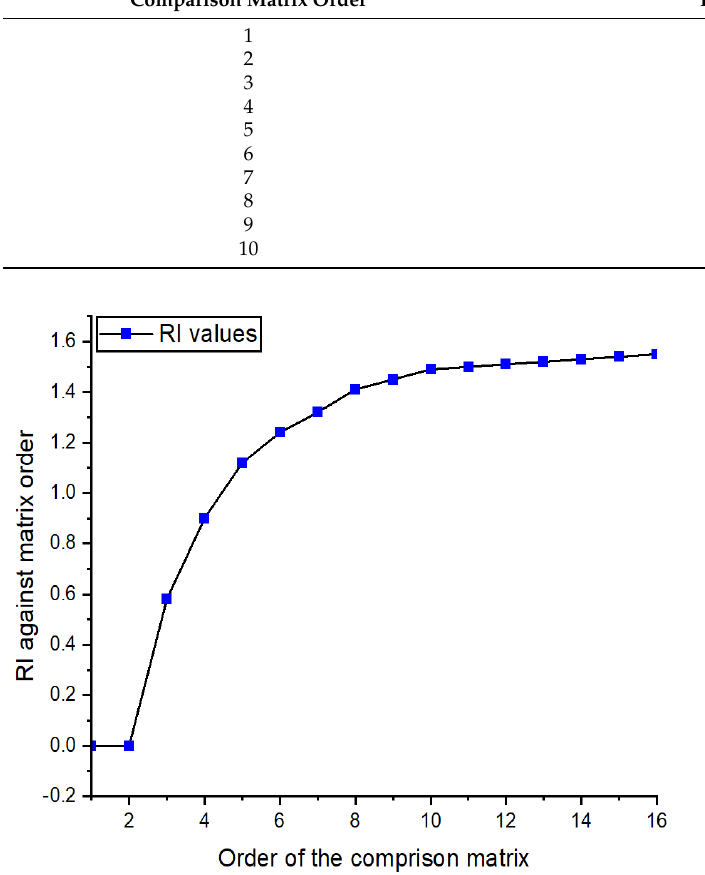
Figure 3. The order of the matrix vs. RI values [46].